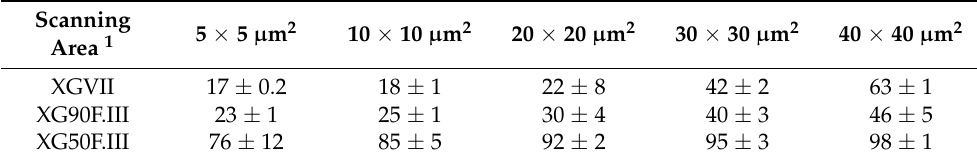
Figure 5. Average pore sizes of the polyphenol-loaded XG/PVA composite hydrogels: ( A ) control samples; ( B ) composite hydrogels prepared with a weight ratio between XG and PVA of 9:1; ( C ) composite hydrogels prepared with a weight ratio between XG and PVA of 3:1; ( D ) composite hydrogels prepared with a weight ratio between XG and PVA of 1:1. The pore sizes were evaluated from three individual SEM micrographs by Image J 1.48v analyzing software. All the data were expressed as the mean ± SD. Table 2. Values of the root mean square roughness for XG-based composite